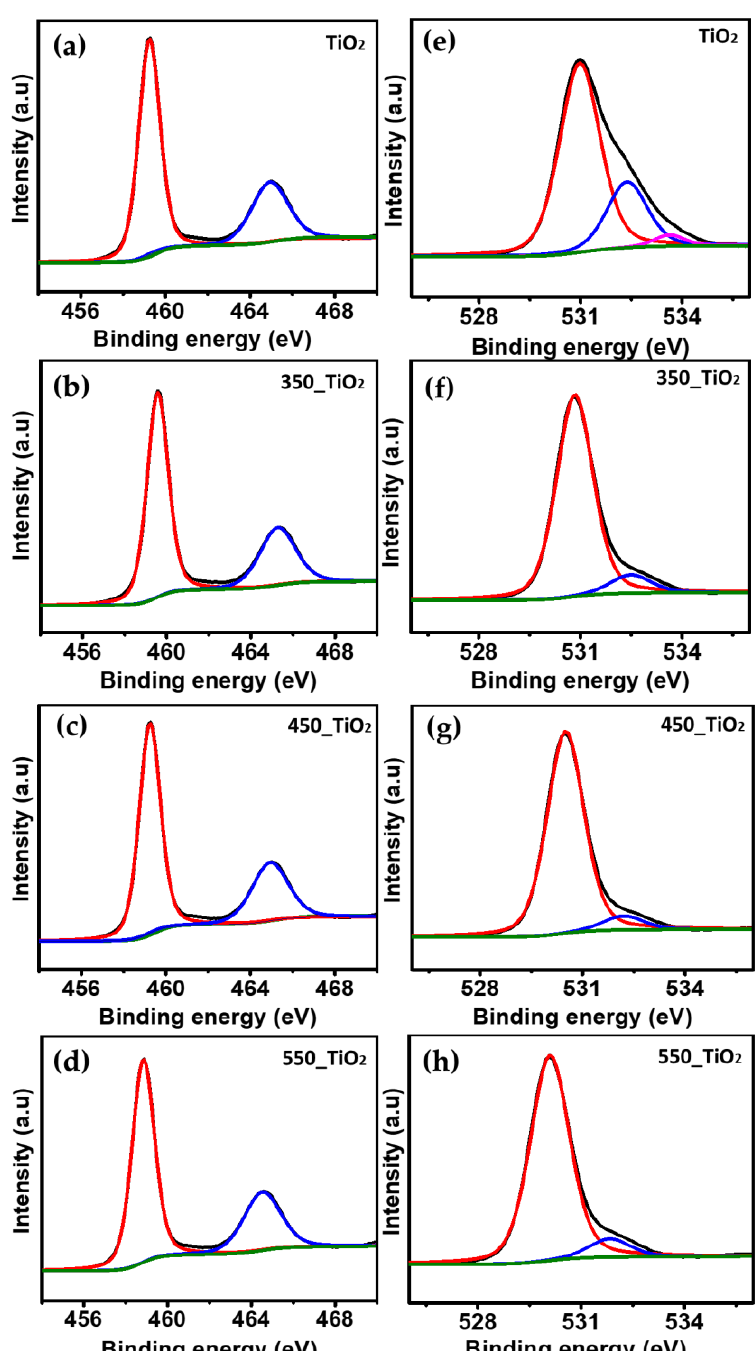
Figure 6. XPS spectra of ( a – d ) Ti2p and ( e – h ) O1s of TiO 2 nanotubes (NTs) calcined at various